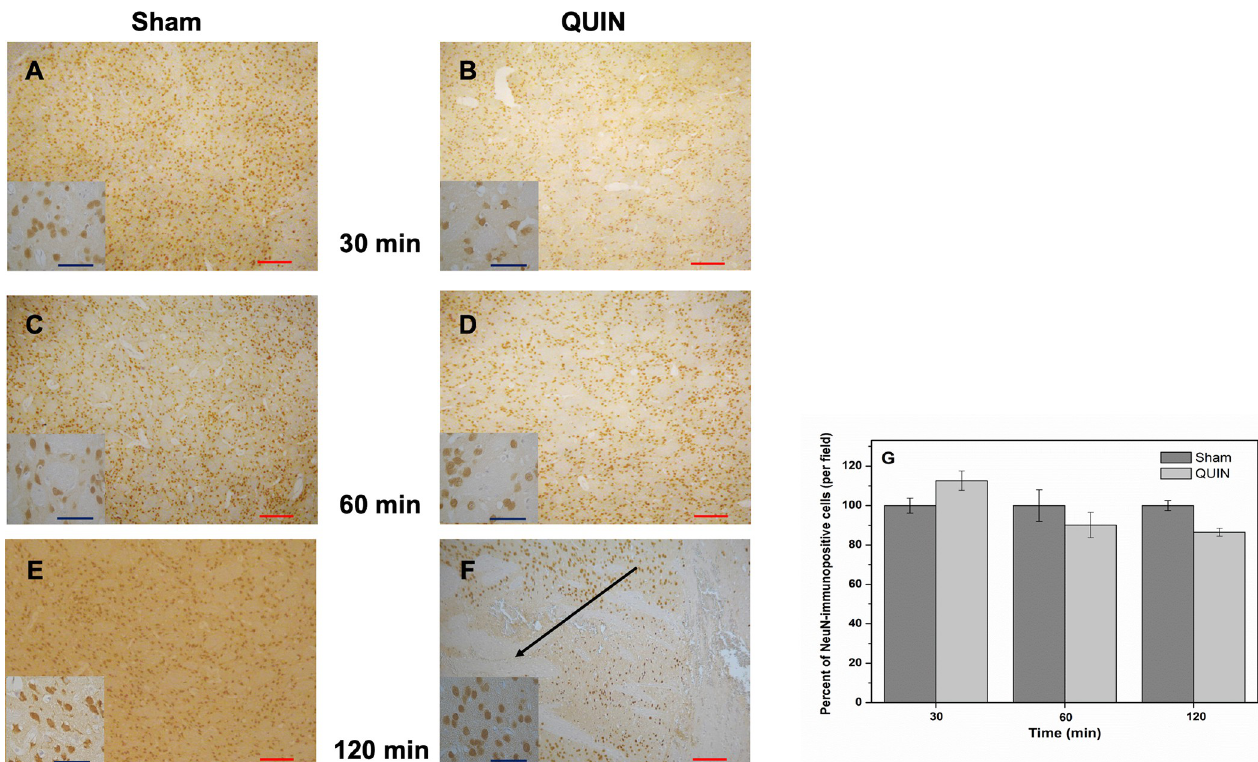
Fig 3. Histochemical alterations produced by QUIN in rats. Peroxidase-based immunohistochemical staining of neuronal cells (NeuN) in striatal coronal sections (10X) of Sham ( A , C and E )- and QUIN ( B , D and F )- treated animals at different post-lesion times (Bar size 100 μ m). Details of cell morphology for each treatment are shown in small squares (40X). The segmentation method was employed for cell counting, and expressed as immunopositive cells. In A , C and E , normal appearance of the striata with normal cell densities are shown. In B , D and F , the striatal appearance at 30, 60 and 120 min post-lesion is presented. Also in F , a considerable loss of neuronal density (indicated by arrow) can be appreciated close to the lesion site. In G , the numbers of immunopositive cells (mean percent ± SD), determined by the segmentation method, are graphically